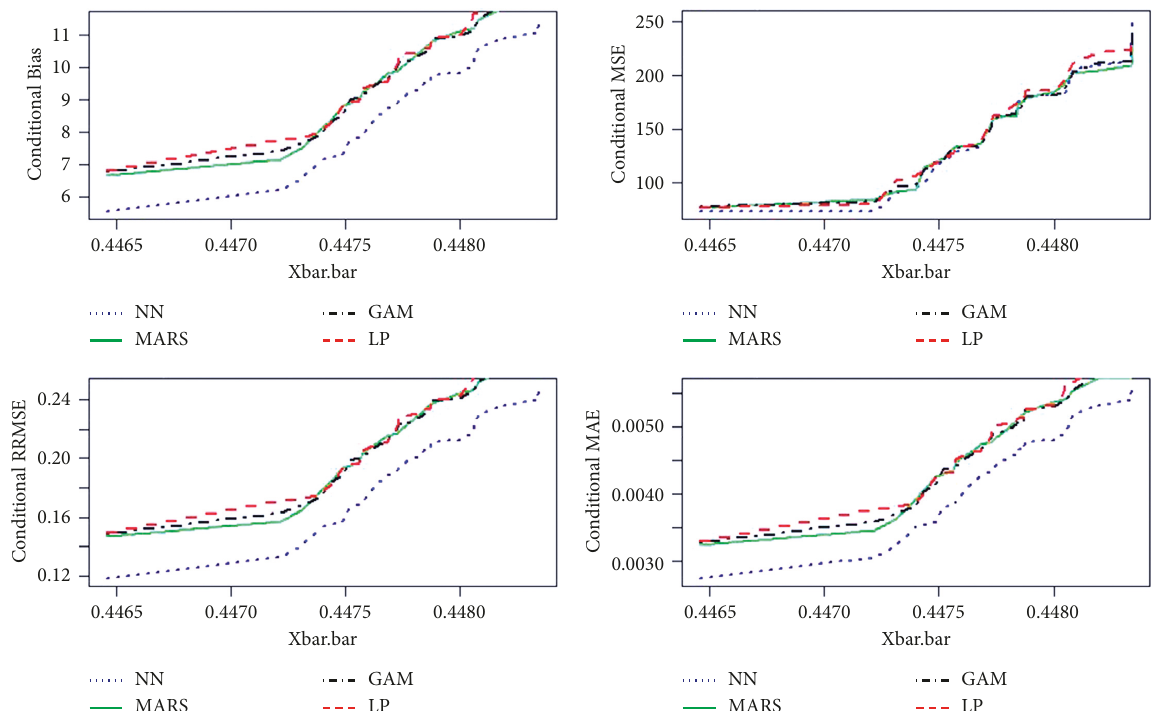
Figure 1: CB, CMSE, CRMSE, and CMAE based on a two-dimensional linear model.